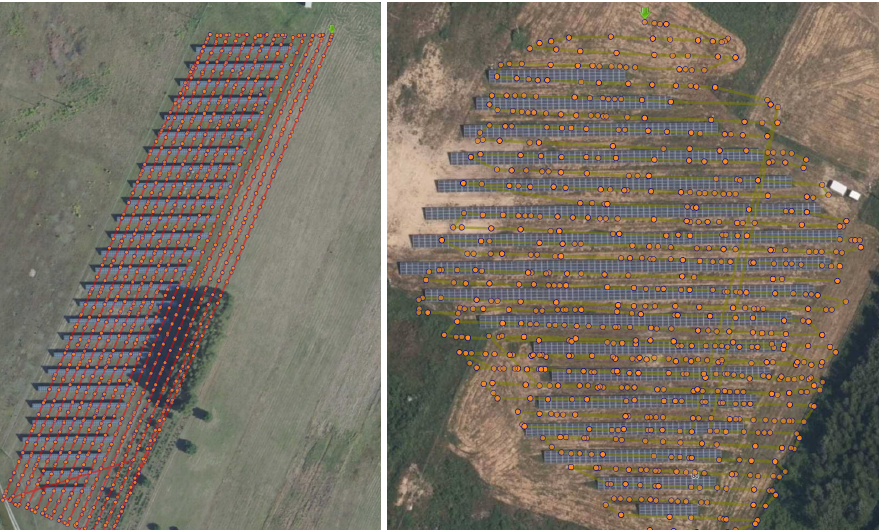
Figure 1. Two exemplary routes of the UAV, with images taken on the spots marked with the orange dots. Note that in the case shown on the left, the drone was programmed based on the non-actual Google Maps, where the farm was not visible. Thus, a large part of the photos was useless. The right inset shows the route controlled manually, and thus it is much less